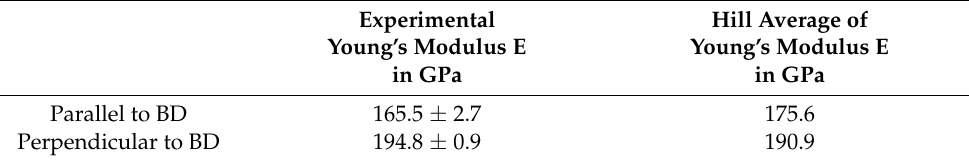
Table 3. Young’s modulus of LPBF samples oriented parallel and perpendicular to BD, determined by the ultrasonic technique and Hill average calculated from EBSD texture data. Hill Average of Experimental Young’s Modulus E Young’s Modulus E in GPa in GPa Parallel to BD 165.5 ± 2.7 Perpendicular to BD